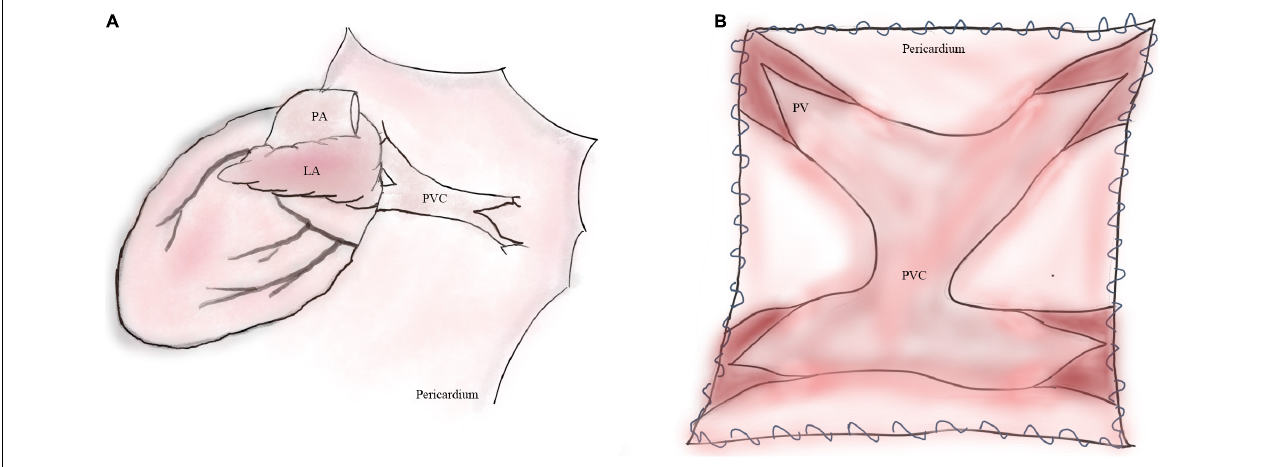
FIGURE 1 | Operative illustrations of primary sutureless repair for TAPVC. (A) Illustration of TAPVC. (B) The left atrial wall is anastomosed to the posterior pericardium. LA, left atrium; PA, pulmonary artery; PVC, pulmonary venous confluence; PV, pulmonary